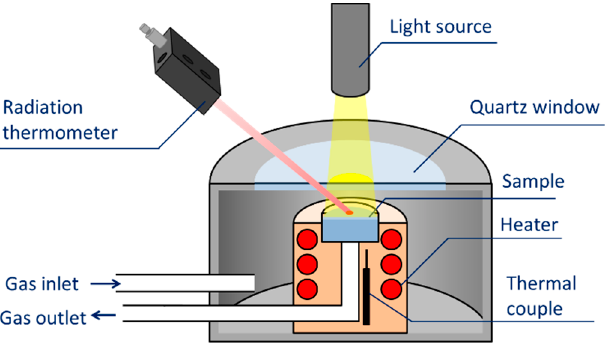
Figure 12. Example of a reactor for photocatalytic methane reforming. The heater and thermocou- ple are equipped and the surface temperature is also measured [22].